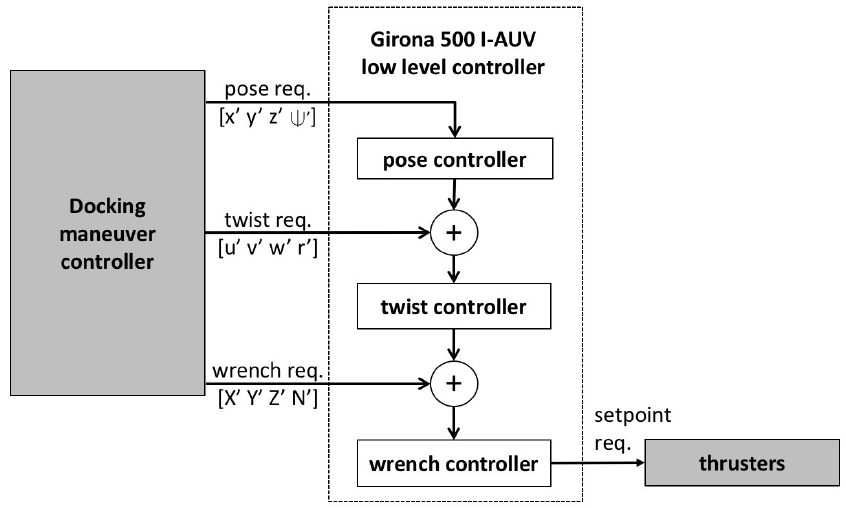
Figure 3. Girona 500 I-AUV low level cascade control